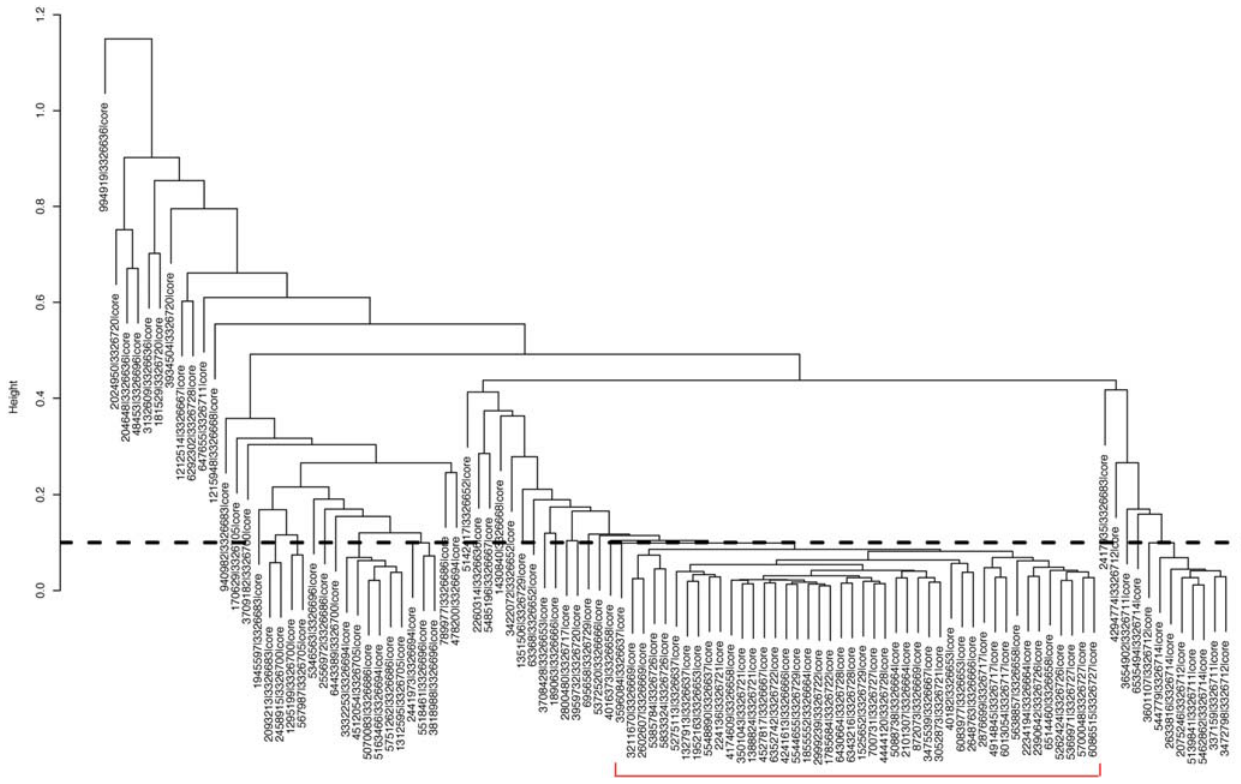
Figure 3. Hierarchical clustering of probe intensities of CD44 core probes. Core probes of CD44 are clustered by average linkage hierarchical clustering based on their intensities in 11 tissues (a total of 33 samples). The distance metric is (1-Pearson correlation coefficient). A total of 44 core probes are selected when we cut the clustering dendrogram at h =0.1 (indicated by the dashed horizontal line).